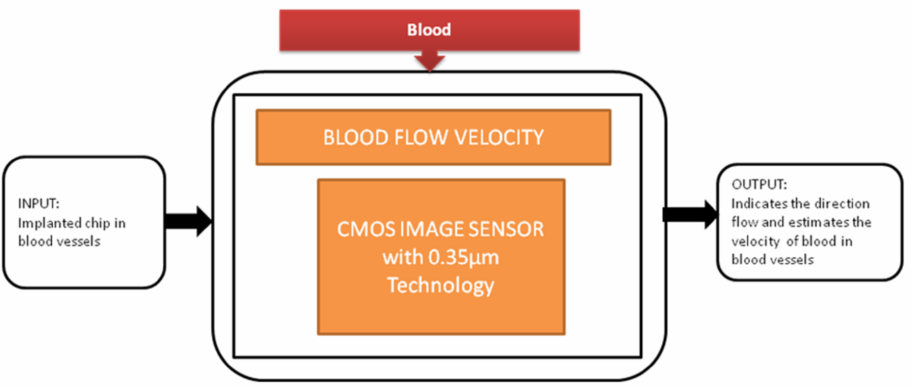
Figure 8. Blood flow velocity